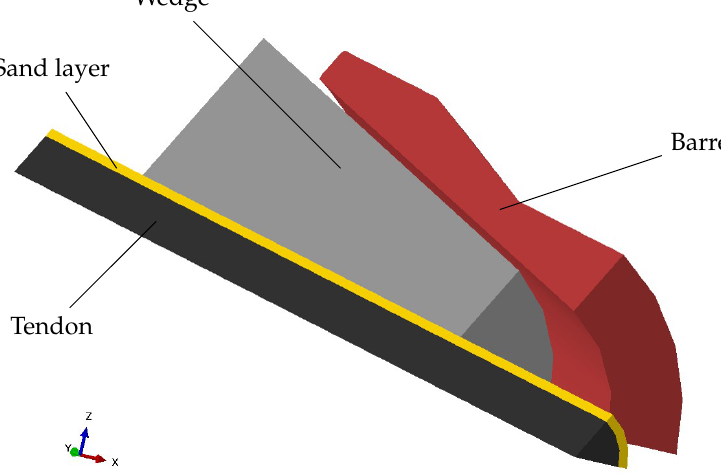
Figure 5. Reduced model simulated in Abaqus.